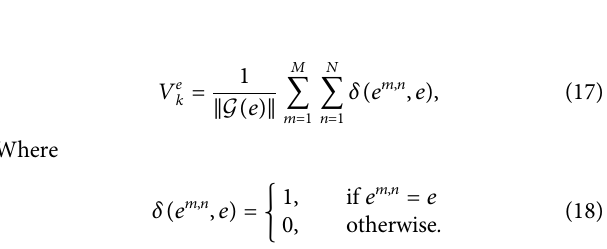
FIGURE 3 | Using edge values weighted by target entropy, the UAV prioritizes the blue particles over the green since the entropy of blue is larger than that of